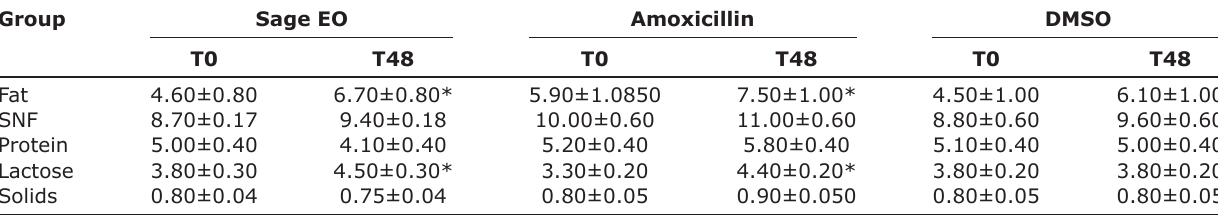
Table-2: Effects of intramammary infusion of sage EO on various milk constituents (%) in Awassi sheep affected with subclinical mastitis (mean±SD). Group Sage EO